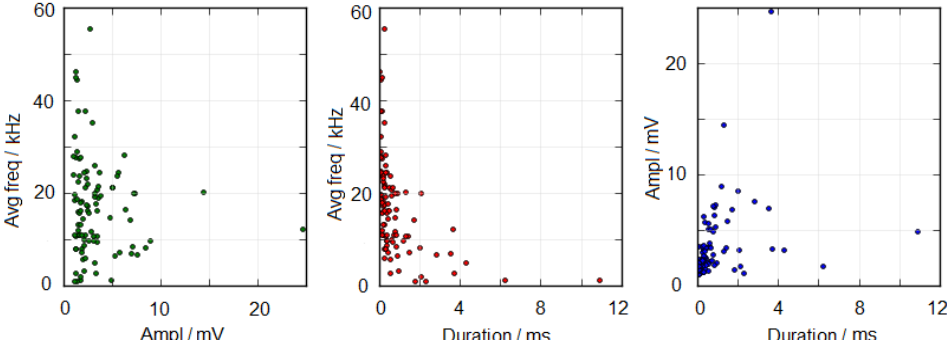
Figure 5. Step load (blue line) and cumulated AE signals time history (red line). Dashed lines correspond to the 3rd, 6th and 8th load